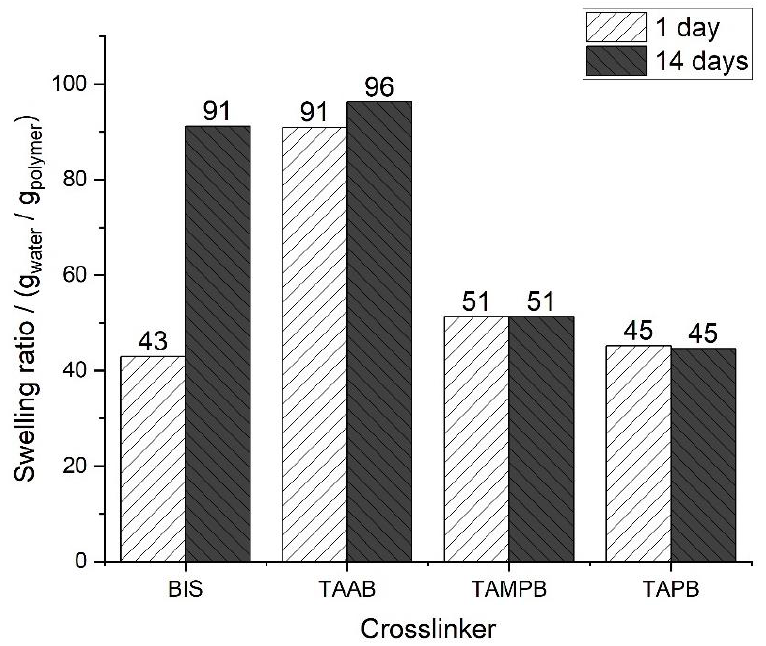
Figure 8. Swelling ratios of cationic poly(DADMAC) gels containing 1 mol% of the cross-linkers 1a-c and BIS after 1 day and 14 days polymerisation time.